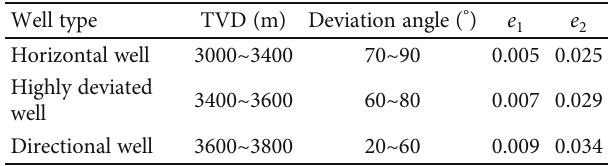
, e , e of Equation (17) in Akpo oil fi 1 2 3